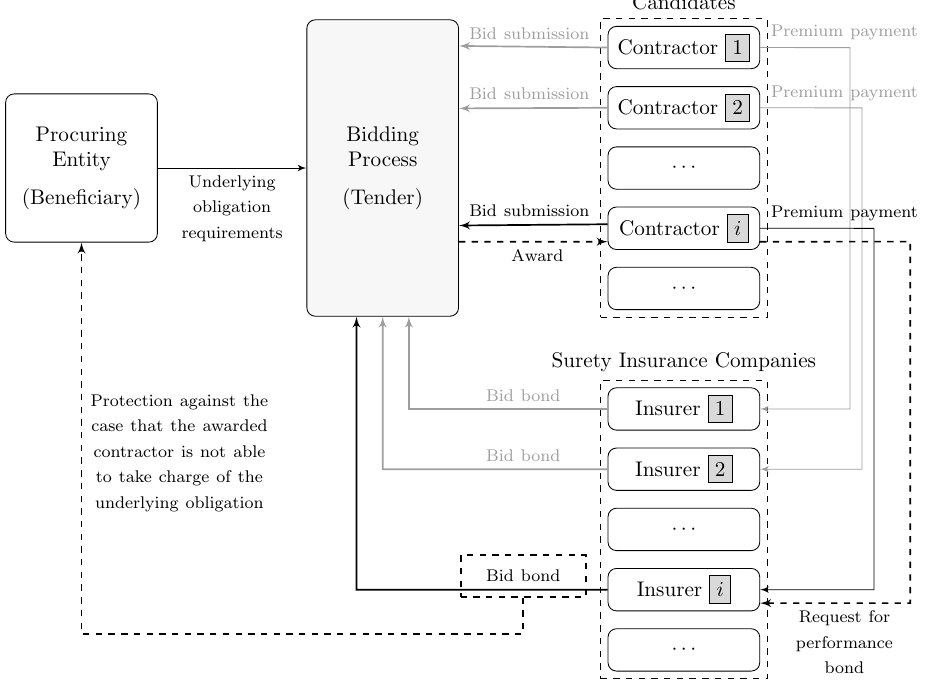
Figure 1. Schematics of the bid bond . The bidding process is represented, in which the bid bond protects the beneficiary and the following performance bond is not issued yet.